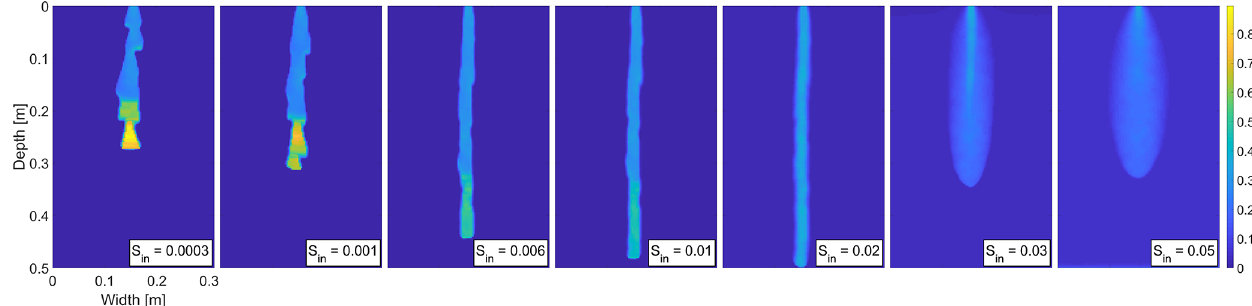
Figure A6. Snapshot of the saturation field at 25min for seven different values of the initial saturation for the distribution which satisfies κ max /κ min ≈ 2 . 45 (the distribution in Fig. A2e). Saturation values are color coded according to the color bar on the right.